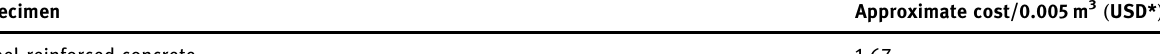
Table 5: Cost analysis Specimen